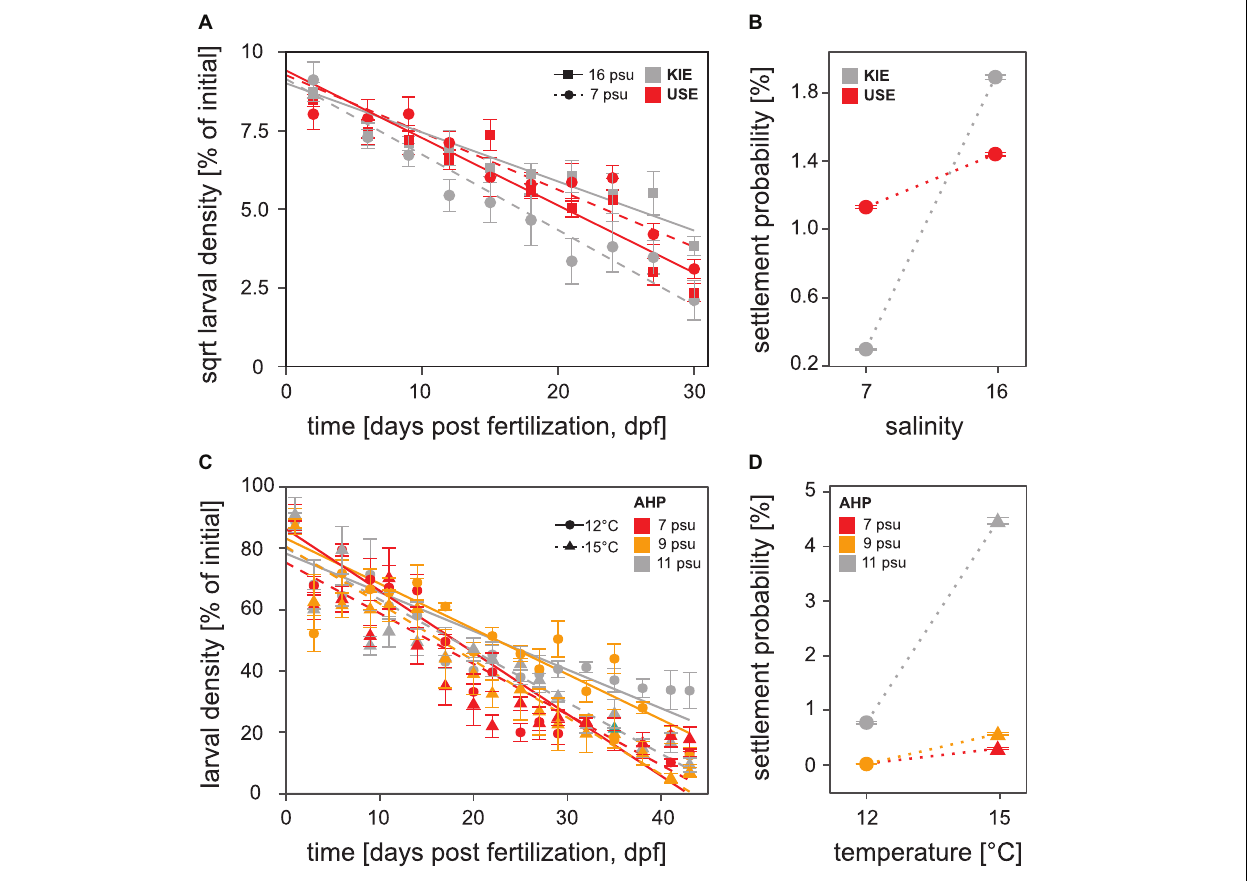
FIGURE 3 | Larval density in cultures and probability of settlement success for all treatments throughout the course of the population comparison (A,B) and simulated desalination experiments (C,D) . Plots (A) and (C) represent changes in larval density over time which indicates mortality and (B) and (D) the probability of settlement success. Symbols represent means and